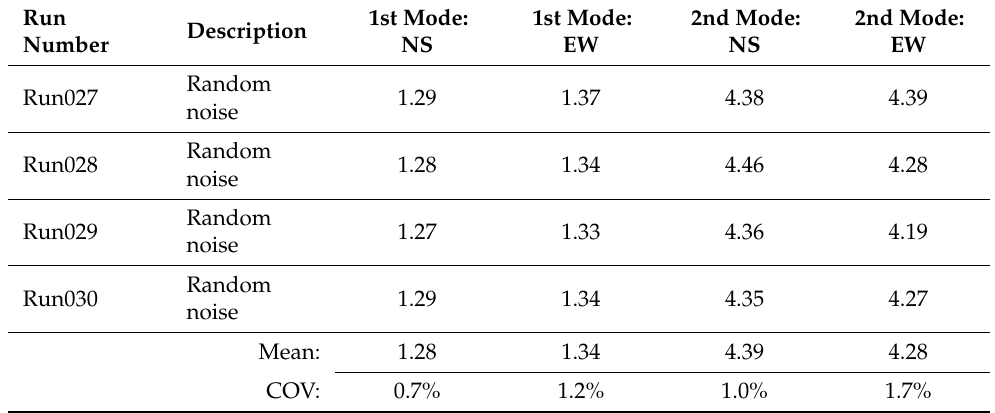
Table 4. Summary of ambient test results.